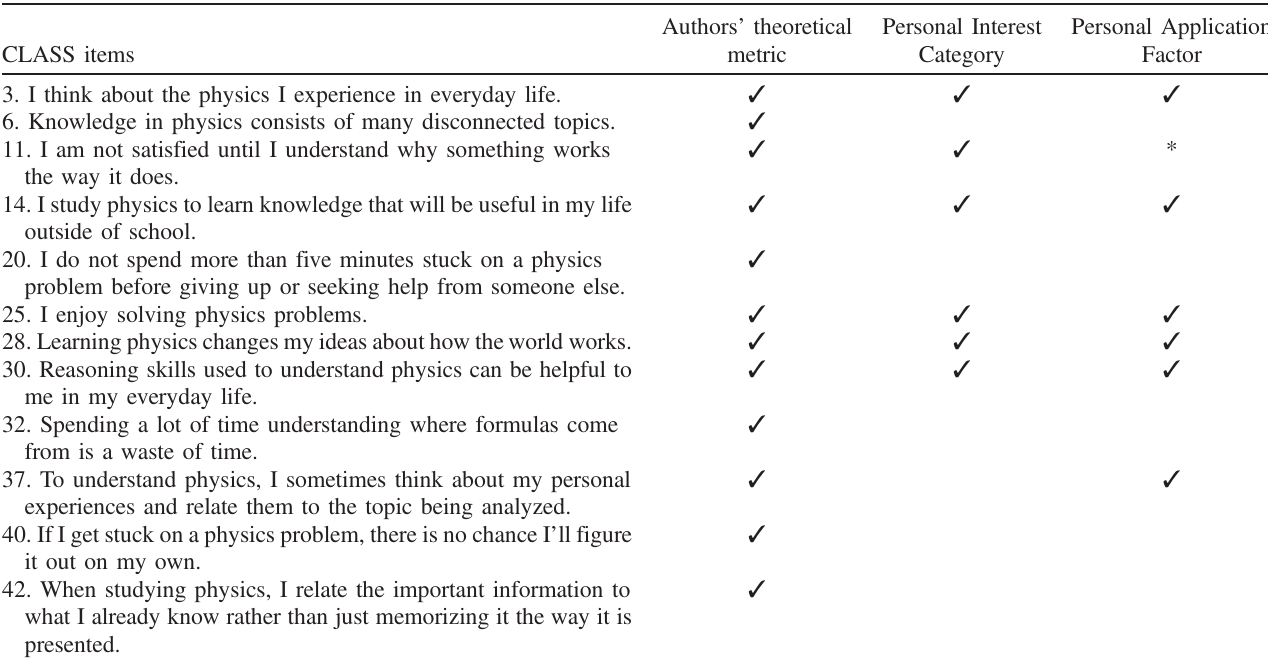
TABLE III. Interest metrics compared in the study, listed by CLASS item number. The Personal Interest Category was designed by the CLASS developers [13] while the Personal Application Factor was identified by Douglas et al. through factor analysis [19]. In the latter, the starred item (11) was found in the original exploratory factor analysis but did not persist through the confirmatory analysis. CLASS